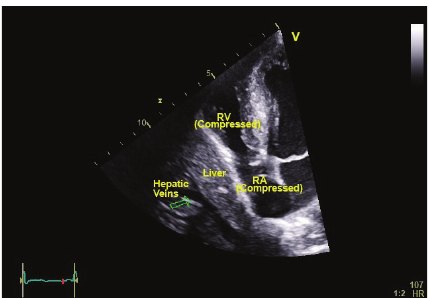
Figure 1: Transthoracic apical four-chamber image obtained after transplant but prior to the diphragm plication. Hepatic compression of the atrium and ventricle is evident here. RV: right ventricle, RA: right atrium.